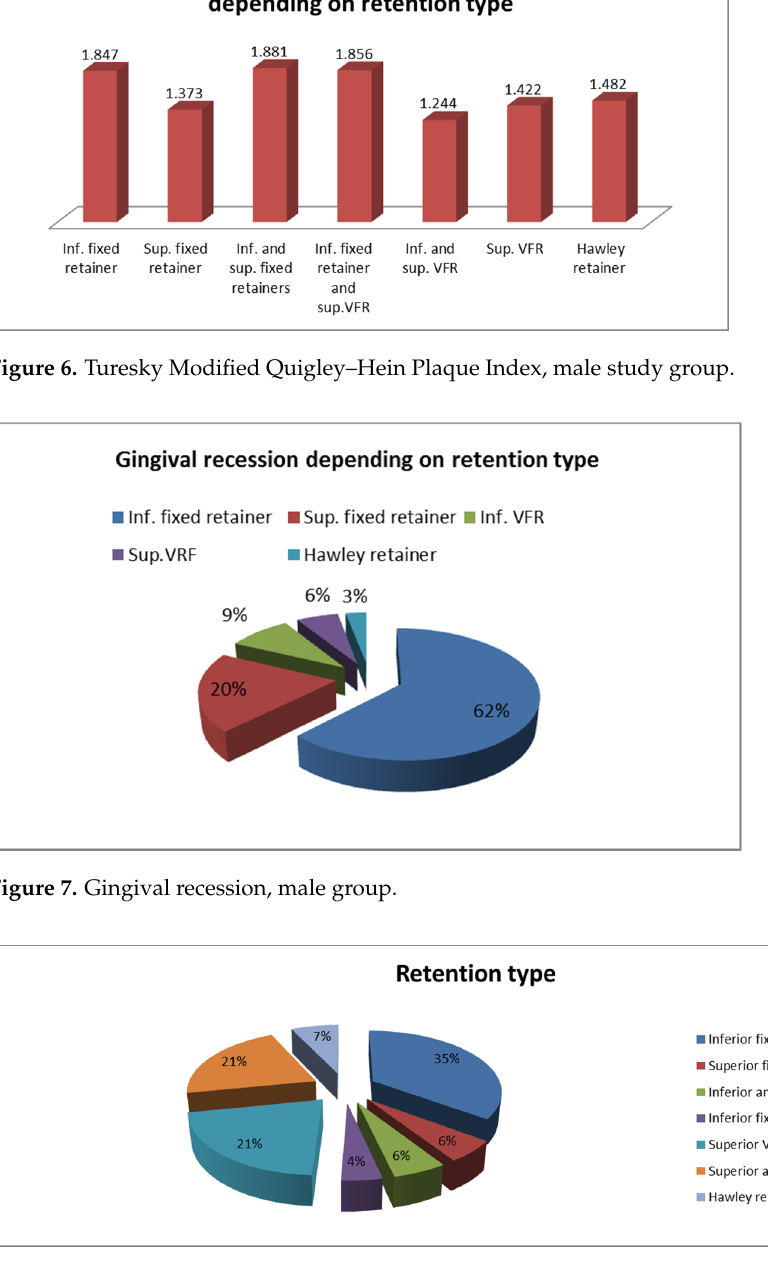
Figure 8. Female patients’ distribution according to retention